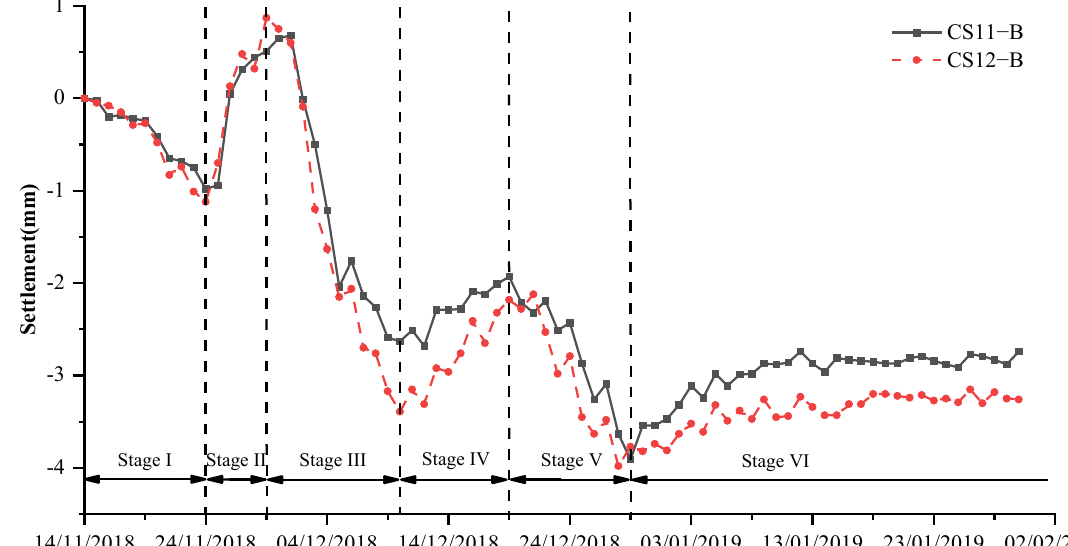
Figure 9. Subsidence evolution of the existing large-diameter tunnel during the undercrossing twin tunnels.